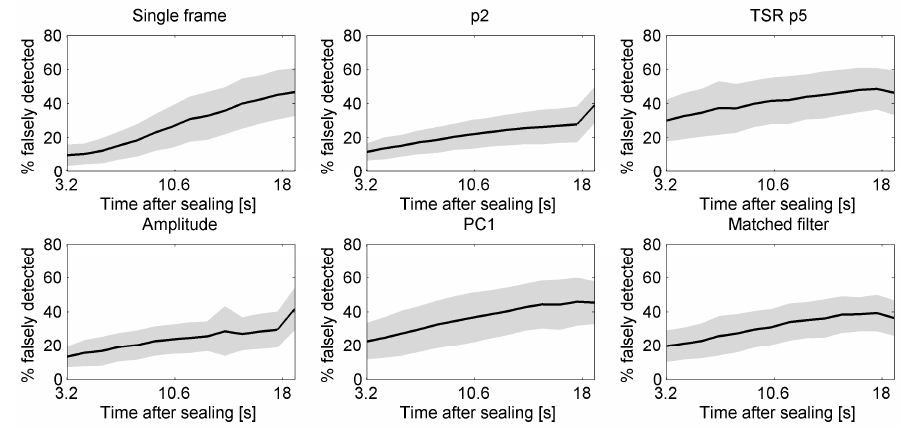
Figure 14. Mean percentage of falsely-detected particles as a function of the time after sealing at which recording was started. The shaded error region represents one standard deviation.